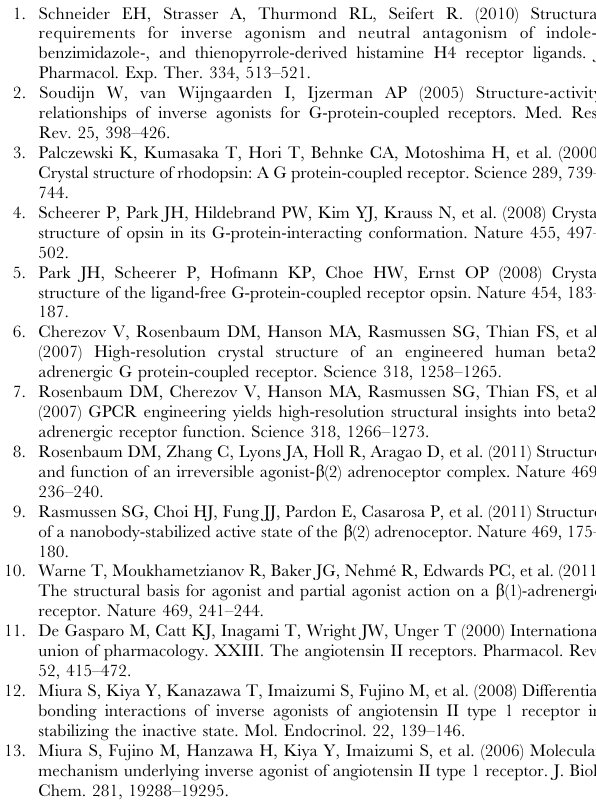
Figure S1 Revised secondary-structure model of rat wild-type AT 1 receptor based on the structure of bovine rhodopsin. Extracellular Cys 18 -Cys 274 and Cys 101 -Cys 180 form disulfide bonds. The epitope tag attached to the C-terminal end that was used for detection by the ID4 monoclonal antibody is underlined. Bold residues indicate mutated sites. (PPT) Figure S2 Putative binding mode of R794847 and Val 116 of AT 1 receptor. Transmenbrans (TMs) are shown as colored ribbons: green (TM3), lime green (TM4), yellow (TM5) and orange (TM6). Yellow dots indicate a hydrophobic environment. (PPT) Table S1 Maximal binding capacities ( B max ) of Ang II to AT 1 wild-type (WT) and mutants receptors.